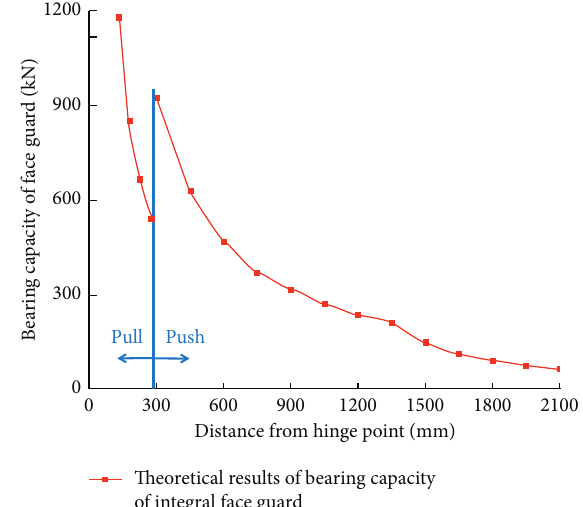
Figure 8: Theoretical value of bearing capacity of the integral face guard.